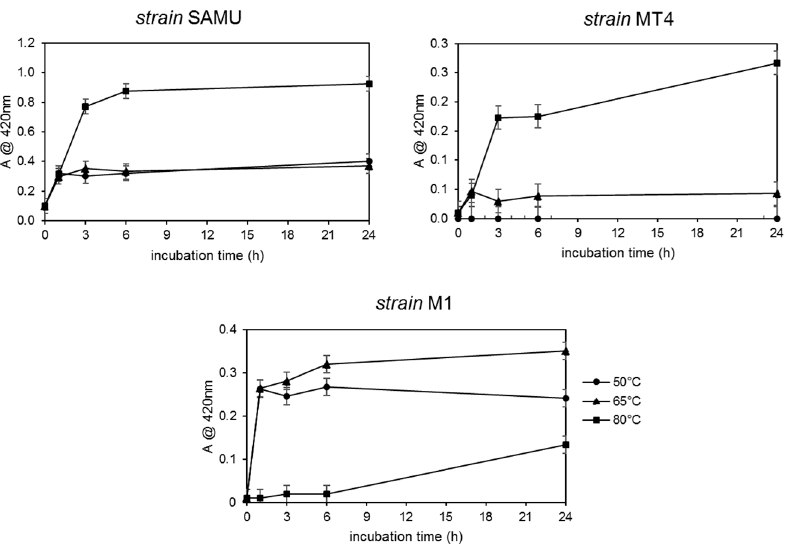
Figure 2. AgNPs yields’ dependence on temperature and time of incubation. The formation of silver NPs was monitored by measuring the solutions’ absorbance at 420 nm.